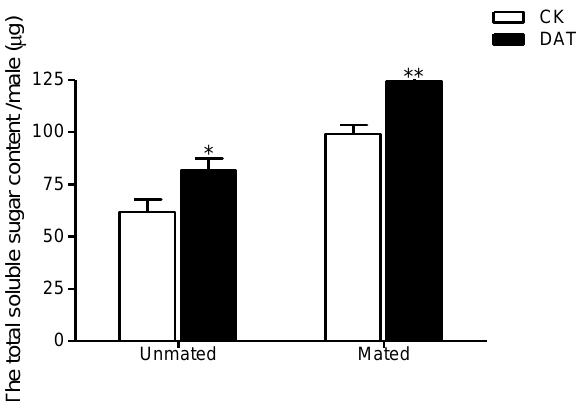
Figure 5. The total soluble-sugar content of males was determined in the CK group (at 19 h after emergence) and DAT group (males treated with 0.01% diallyl trisulfide for 7 h at 12 h after emergence) both before and after mating. The data in the figure are presented as the mean ± SEM. Asterisks depict significant differences relative to the control treatment (*, p < 0.05; **, p < 0.01).